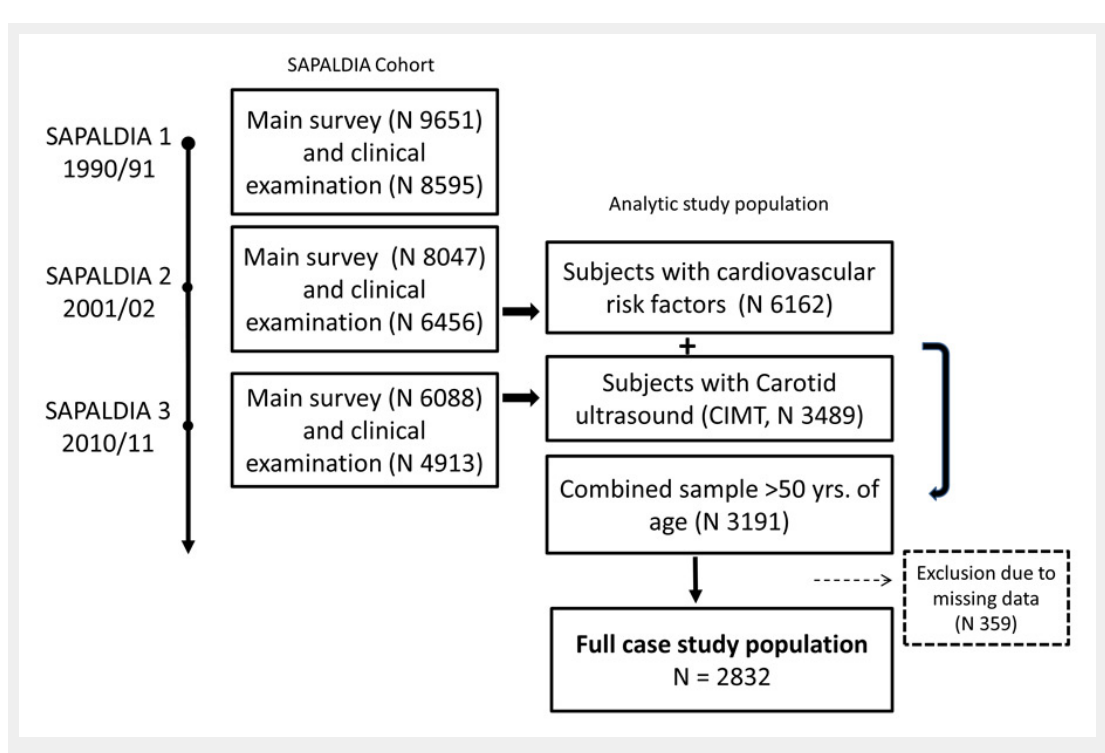
Flow chart. SAPALDIA – follow-ups and timing of data collection of cardiovascular risk factors and CIMT assessment.